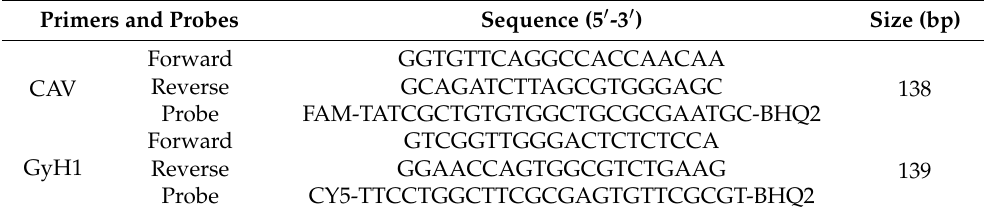
Table 1. Real-time PCR primers and probes.